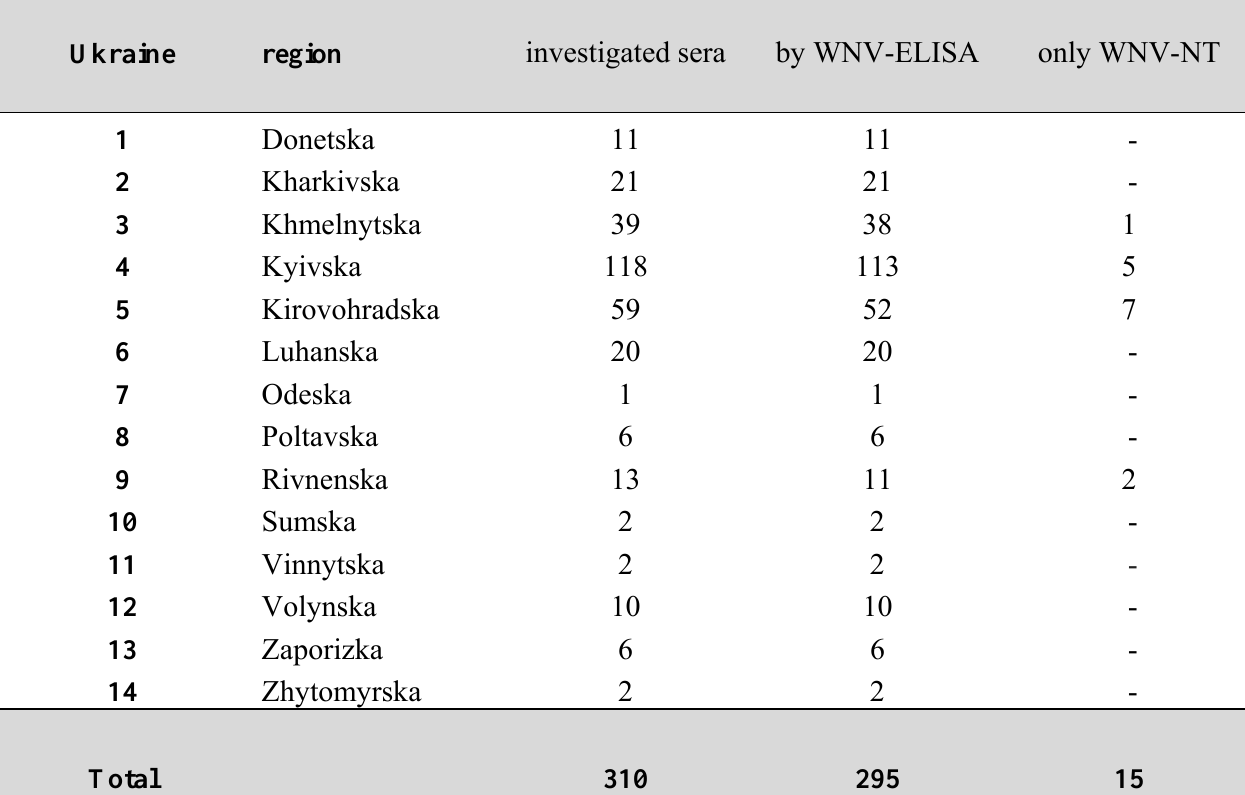
Table 1. Distribution of serum samples by regions (oblasts).